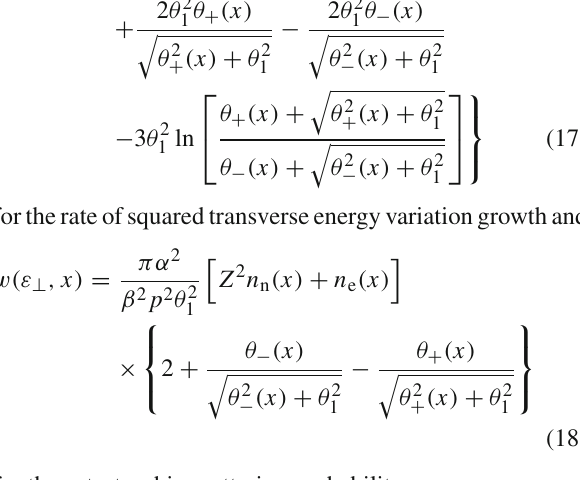
cross section on both nuclei with local number density n n ( x ) and electrons with local number density n e ( x )